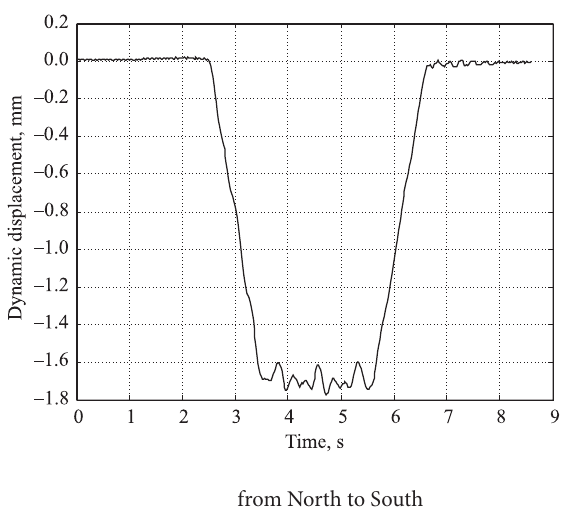
Fig. 7. Measured dynamic displacement